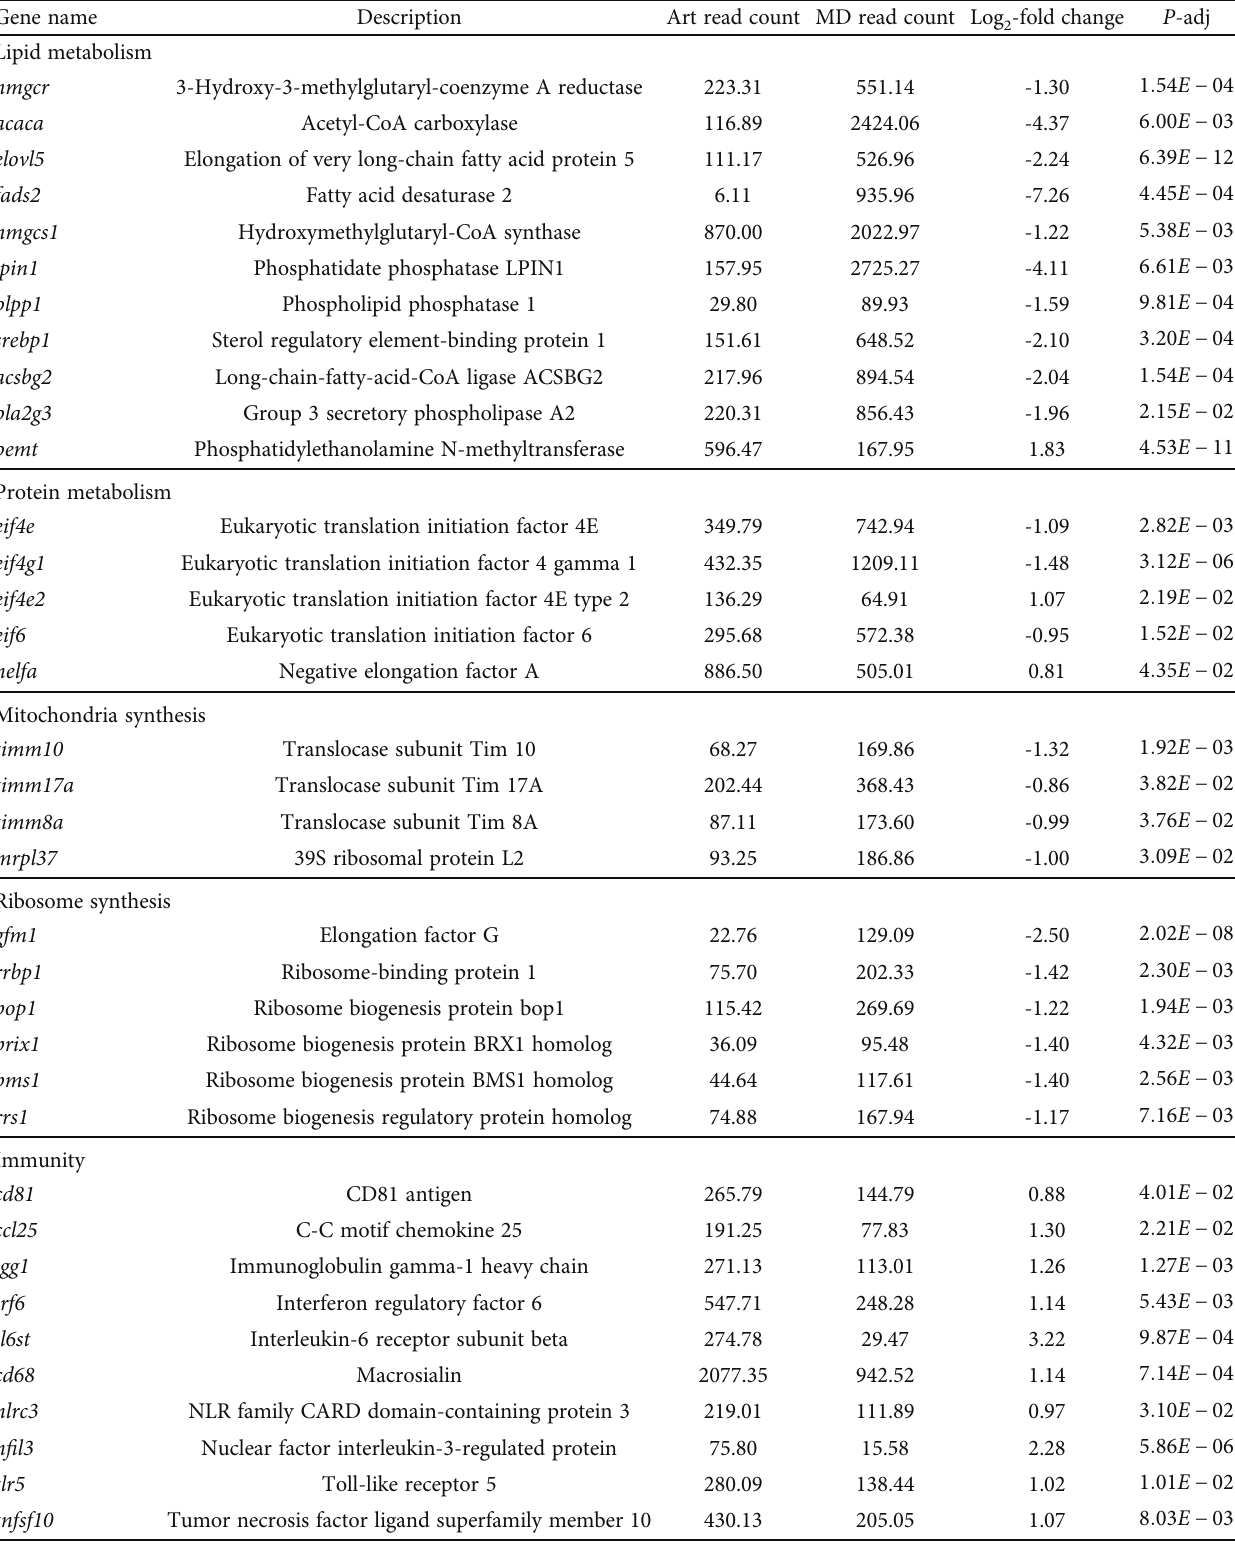
Table 6: A partial list of the di ff erentially expressed genes (DEGs) in liver tissue of larvae fed art or